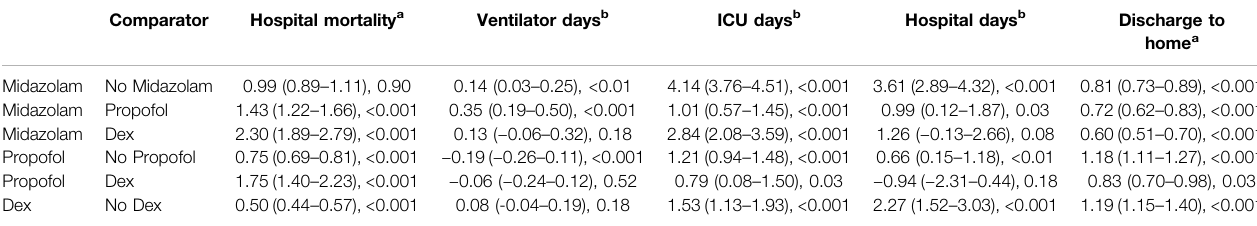
TABLE 3 | Results of multivariate analysis in patients with or at risk for acute respiratory distress syndrome.